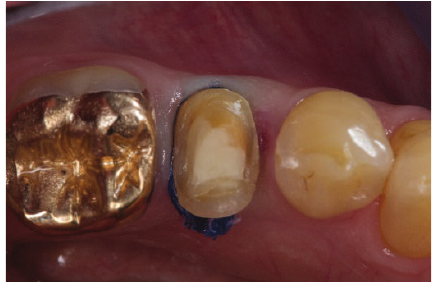
Figure 3: Finished preparation with retraction cords placed.